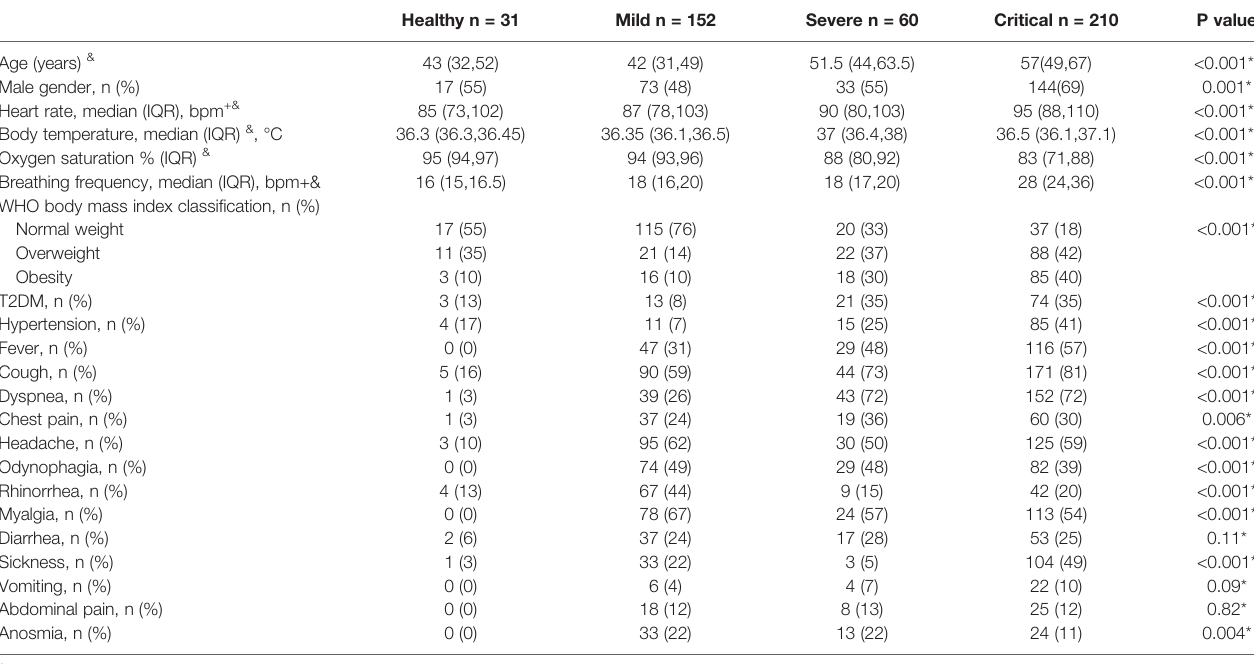
TABLE 1 | Anthropometric and clinical characteristics of the studied